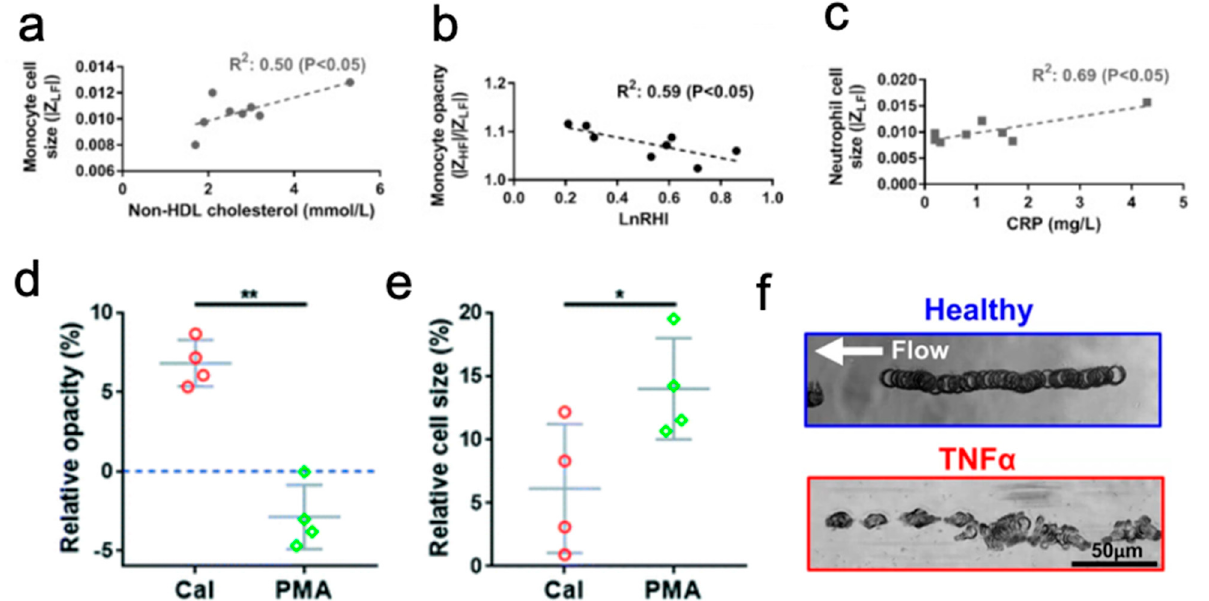
Figure 6. Interpretation of results from impedance measurements ( a – c ). Correlations between ( a ) monocyte cell size and cell lipid content, ( b ) monocyte opacity and vascular function as measured by logarithm of reactive hyperemia index (lnRHI), ( c ) neutrophil size and CRP levels. Panels a-c reprinted with permission from [96], Copyright 2018 with permission from Elsivier. Changes in neutrophil ( d ) opacity, and ( e ) size when treated with calcium ionophores (CaI) and phorbol 12-myristate 13-acetate (PMA) to stimulate NETosis. Both figures are normalized to a control of unstimulated neutrophils. Panels d-e reprinted used with permission of MDPI, from [97]; permission conveyed through Copyright Clearance Center, Inc. ( f ) Time lapse captures showing the difference between a healthy rolling profile (top) and the discontinuous cell “flips” when treated with TNF- α (bottom), panel used with permission of Nature Publishing Group, from [99]; permission conveyed through CC BY